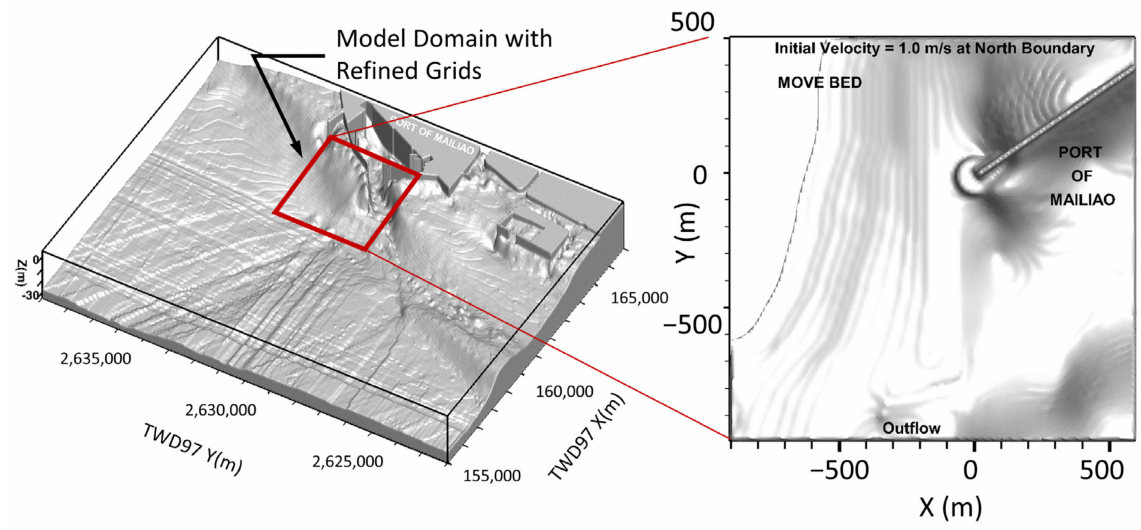
Figure 38. Modeling domain with high resolution computation